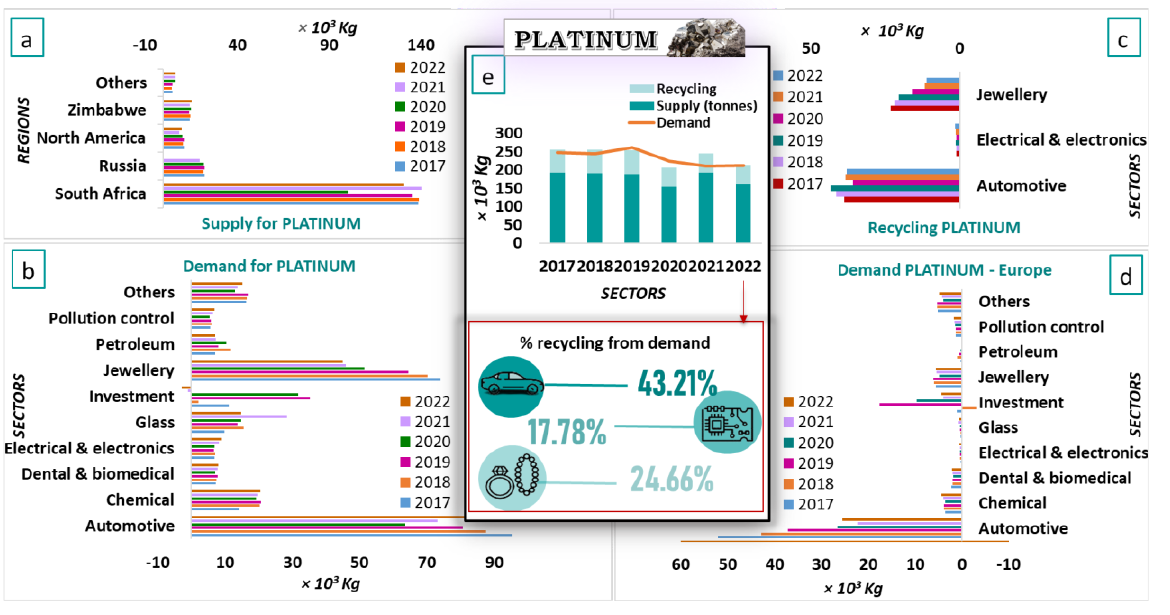
Figure 4. ( a ) Platinum supply by region from 2017 – 2022; ( b ) Platinum demand by sectors from 2017 – 2022; ( c ) Platinum Recycling by sectors from 2017 – 2022; ( d ) Platinum demand in Europe from 2017 – 2022; ( e ) Global platinum recycling, supply and demand from 2017 – 2022 (according to the data from [49]).